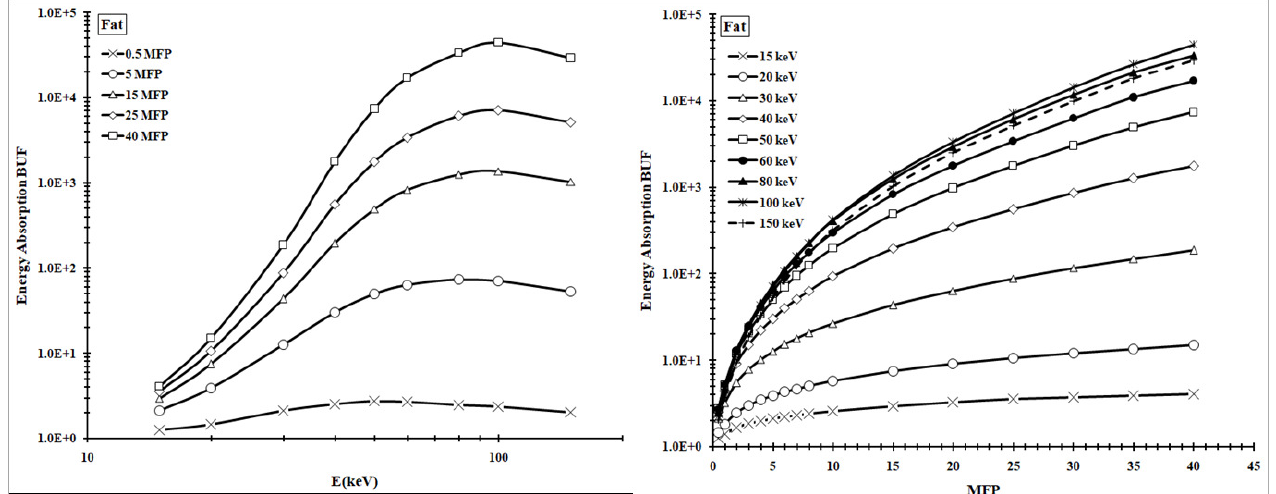
Figure 6. Energy absorption buildup factor for fat tissue as a function of: ( left side) photon energy for fixed depths between 0.5 and 40 mfp and ( right side) depth for fixed photon energy between 15 and 150